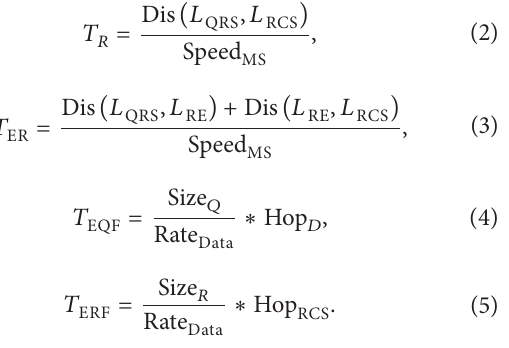
a query message from 𝐿 to 𝑇𝑆 , and Expected Query QRS ), time needed Processing and Response Forwarding Time ( 𝑇 ERF to process the query and forward the response message to 𝑅𝐶𝑆 , are estimated as in (4) and (5), respectively. In these equations, we estimated the number of hops for given two locations using the sensor density, communication range, and the